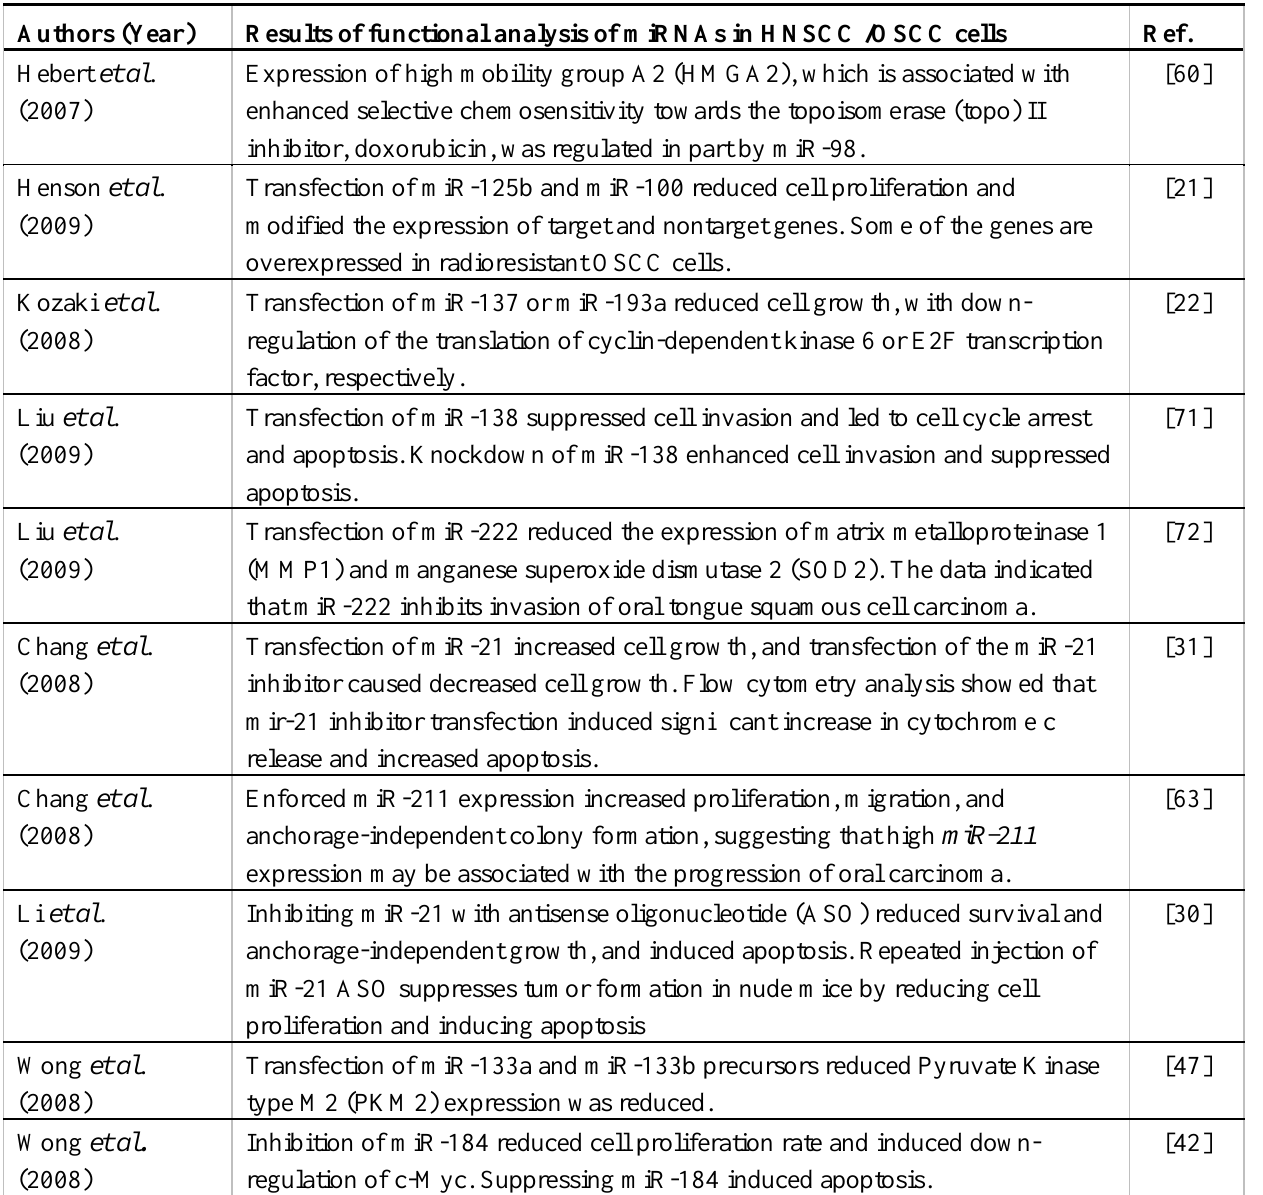
Table 2. Function of miRNAs in HNSCC/OSCC cells reported in the recent literature. Results of functional analysis of miRNAs in HNSCC /OSCC